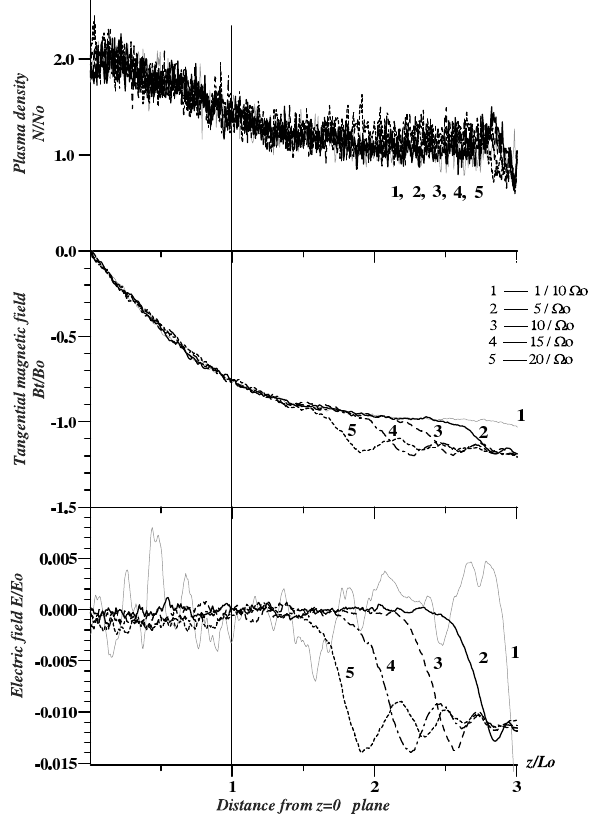
Fig. 1. Profiles of plasma density, the magnetic field tangential com- ponent, and the electric field, for initial moments of the CS evolu-